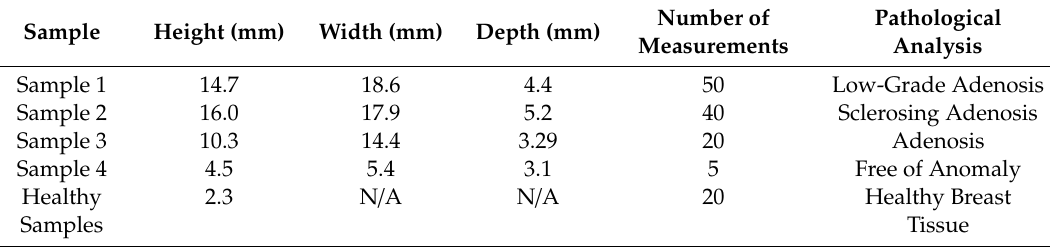
Table 1. The dimensions of the samples, results obtained from pathological examination and the total number of measurements.